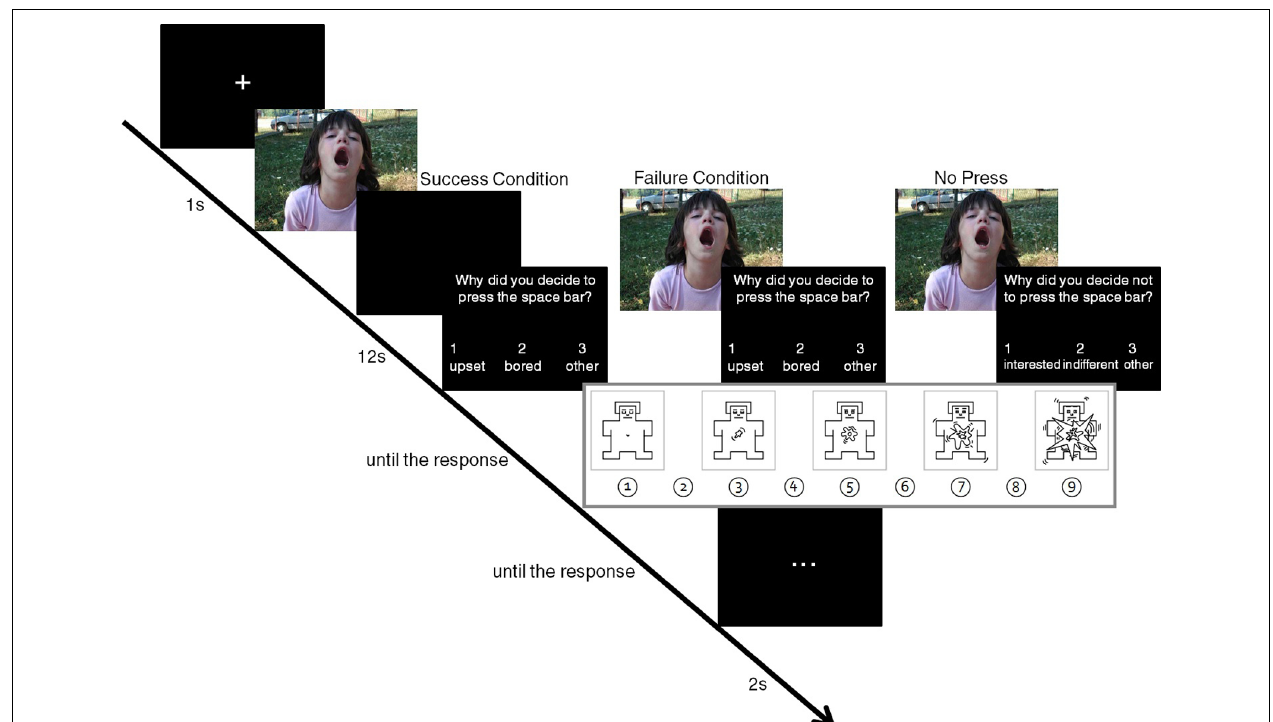
and “Other.” These full descriptions are not presented in the figure proper due to space constraints; instead we use the terms “upset,”